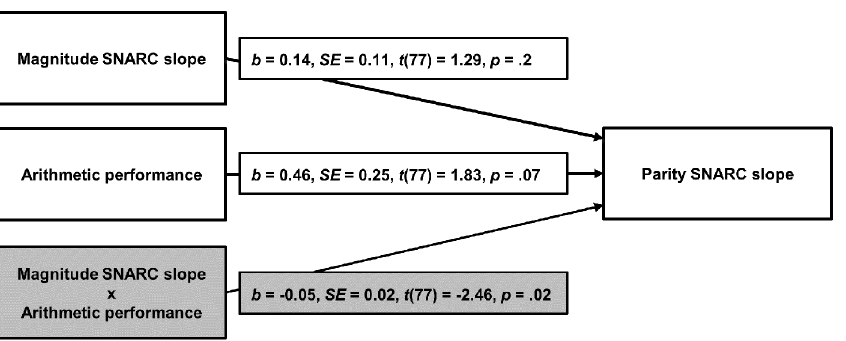
Figure 1. Simple moderation analysis results for arithmetic performance with unstandardized regression coefficients.